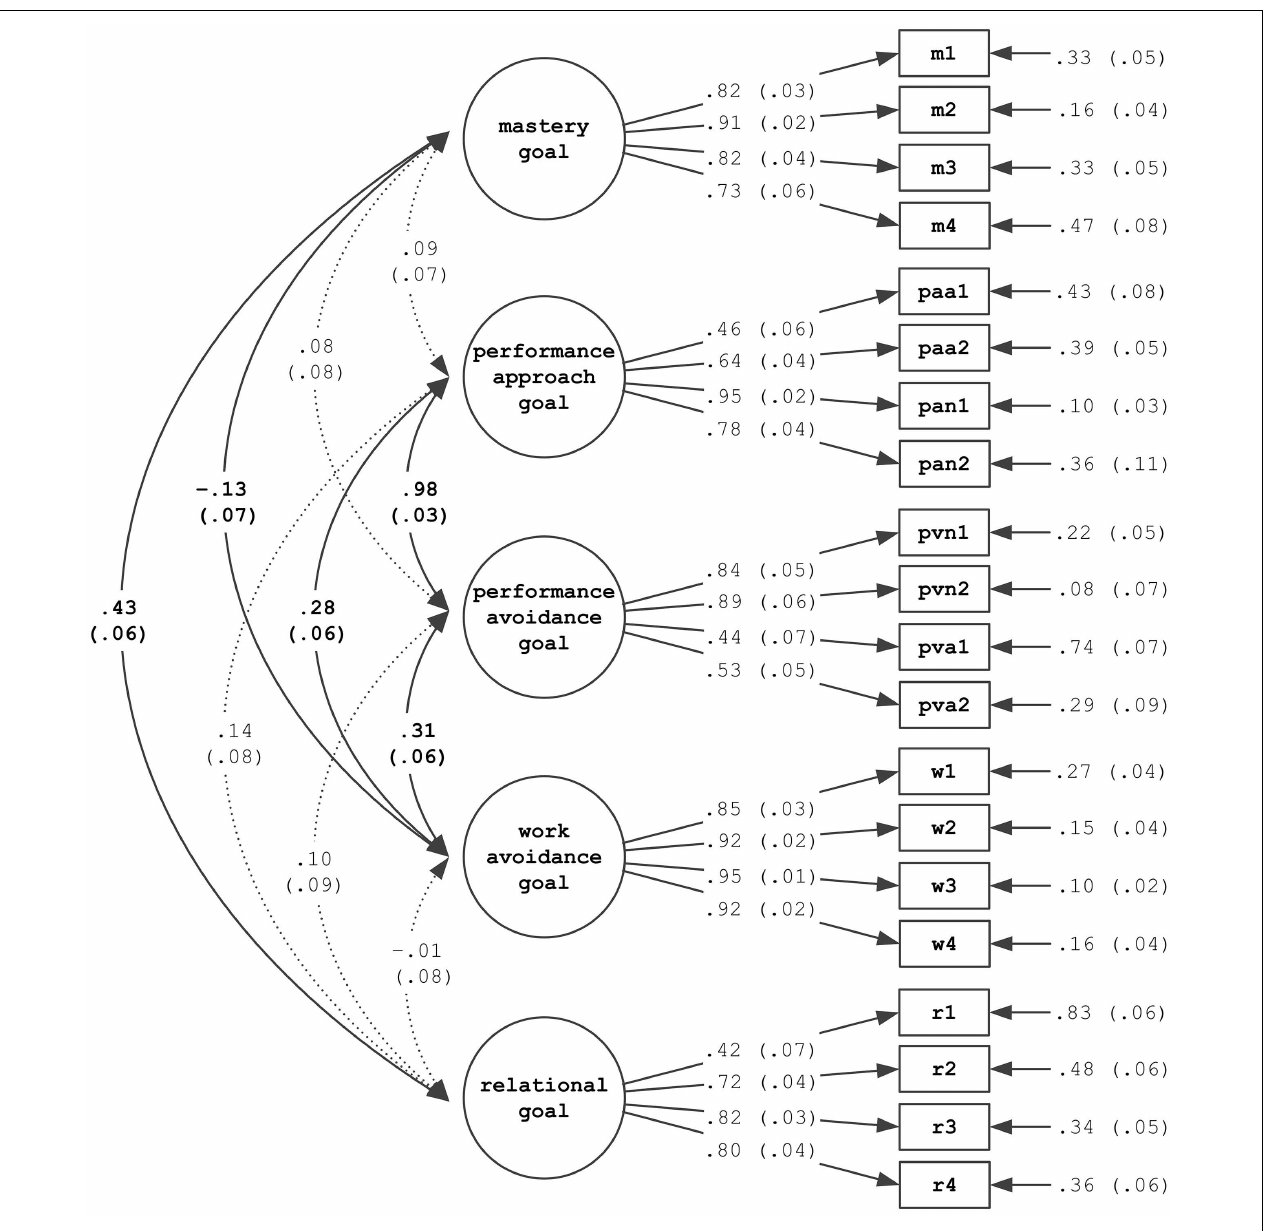
FIGURE 1 | Factor loadings and factor correlations of the five factor model (correlated errors are not displayed; non-significant factor correlations are displayed in dotted